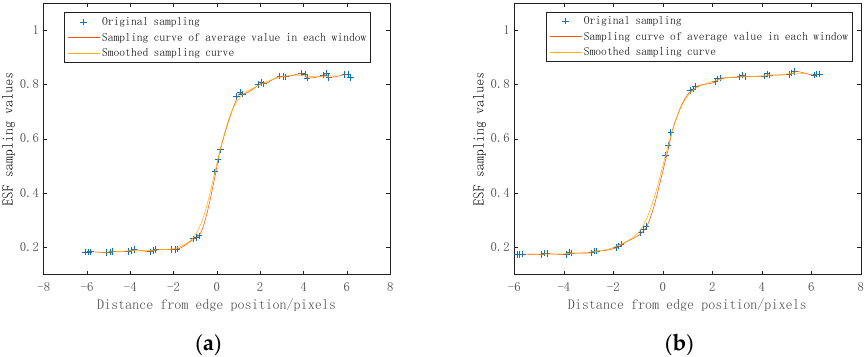
values values/fitted sampling